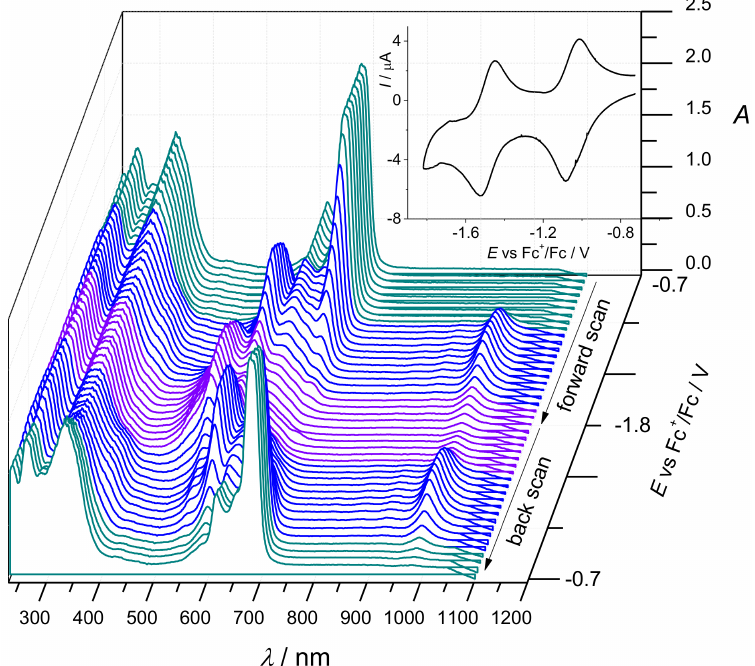
Figure 2. In situ UV-vis-NIR spectroelectrochemistry of complex 9 (Ni − Zr) in acetonitrile (ACN)/ n - Bu 4 NPF 6 in a thin layer honeycomb spectroelectrochemical cell: potential dependence of UV-vis-NIR spectra with corresponding cyclic voltammogram (scan rate v = 10 mV s − 1